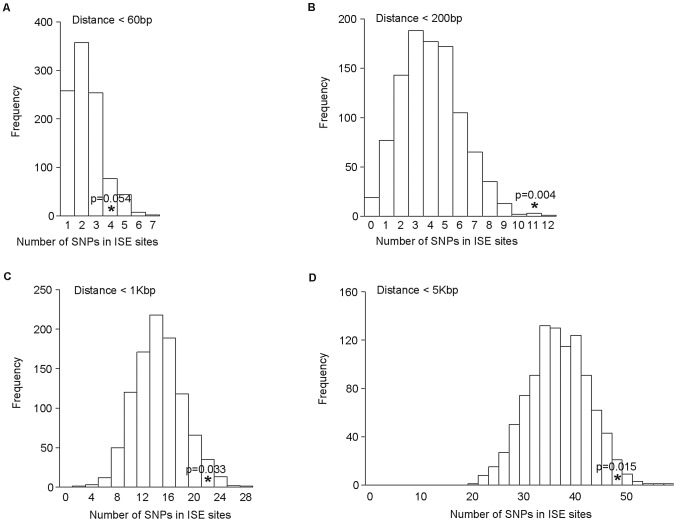
No Difference in Enrichment of Human Complex Trait-Associated SNPs among ISE SNPs Classified According to Physical Distance from the Associated Alternatively Skipped Exon's Splice Site Junction.The distribution of the number of predicted exon-skipping ISE SNPs observed for each of the 1,000 random draws of the 3,358 SNPs from bins matched for minor allele frequency (MAF, CEU) to the 3,358 SNPs downloaded from the NHGRI catalog (bins include all SNPs in HapMap, CEU) is shown in the bar graphs. A solid asterisk represent the actual number of 4, 11, 21, and 49 predicted exon-skipping ISE SNPs away from the associated skipped exon within the tested distances as shown in panel A, B, C, and D, respectively.